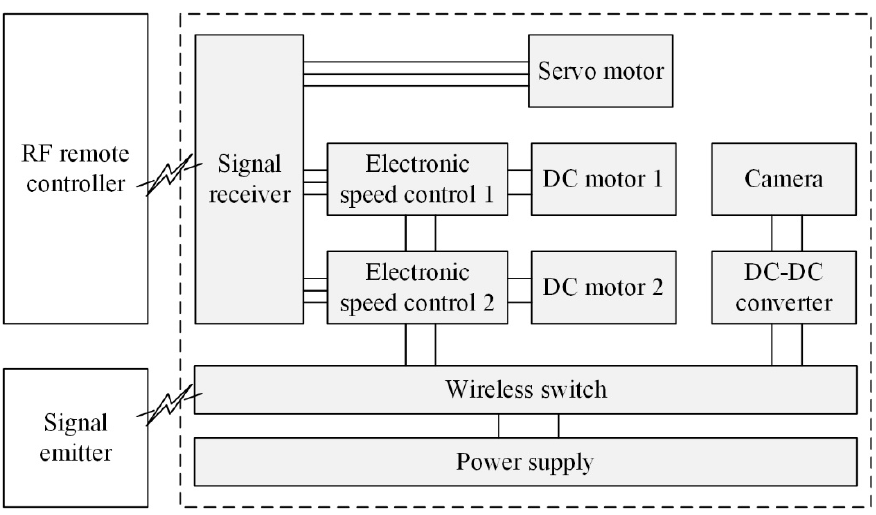
Figure 3. Schematic of electrical actuation and control system.